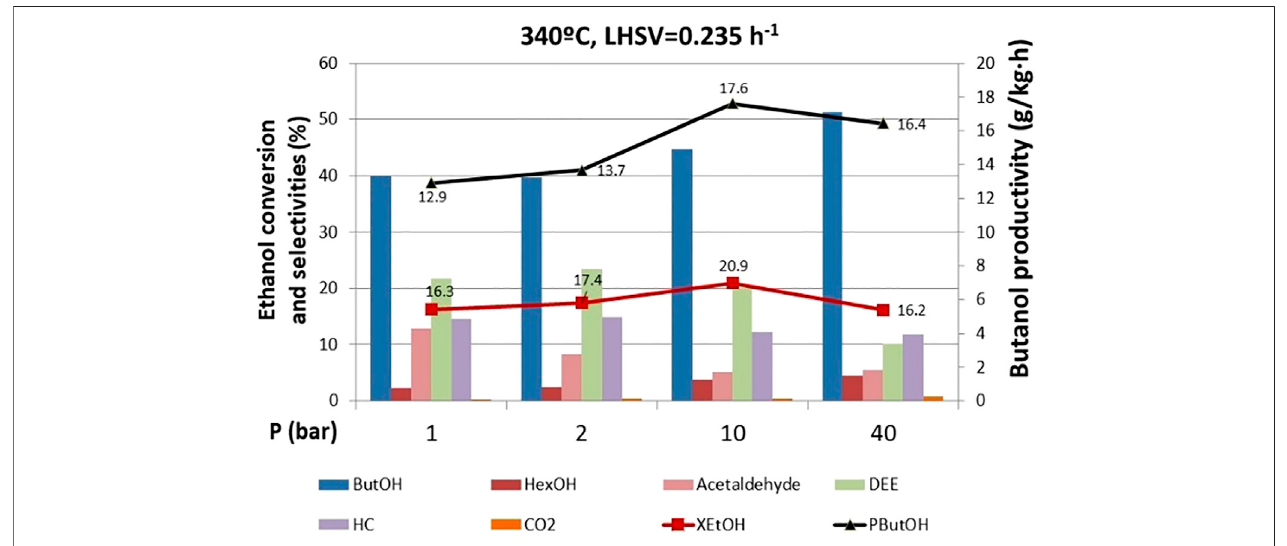
FIGURE 6 | Effect of pressure on ethanol conversion, butanol productivity, and selectivity to products. ButOH = butanol; HexOH = hexanol; HC = hydrocarbons; DEE = diethyl ether.